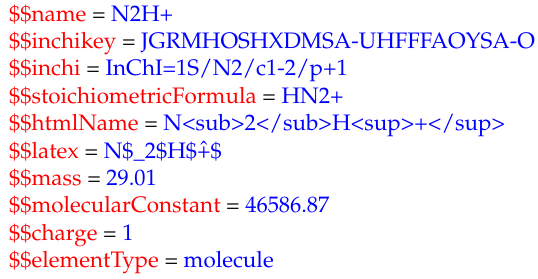
Table A1. Example of a “Element” section input for N 2 H + as requested by the import script. The metadata are in red and the values in blue. The metadata “elementType” have fixed values chosen among [molecule | atom | negative molecular ion | positive molecular ion | particle]. The metadata $$mass give the molecular weight in atomic mass unit (in the species database, it is used to infer the mass number). The metadata “molecularConstant” is historical, concerns the rotational constant of a linear molecule, and has units in MHz. “htmlName” uses normal HTML language and is used in the BASECOL web interface.